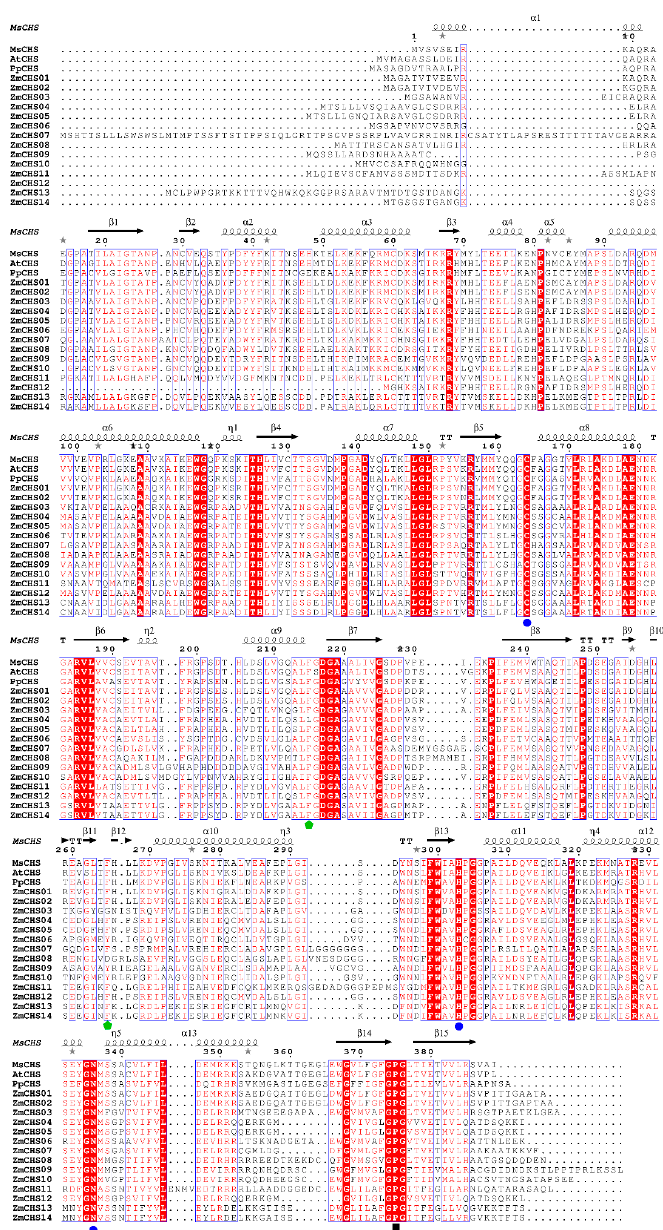
Figure 3. Sequence alignment of ZmCHSs against the other plant CHSs. The first line represents the secondary structure of Medicago sativa chalcone synthase (MsCHS). The blue boxes and red letters represent conserved residues. The red regions represent sequences of strict sequence conservation. The black wave lines and black arrows represent α -helix and β -pleated sheet. The catalytic triad of CHSs, residues connected with CoA-binding and CHS family-specific Pro375 are labeled with blue points, green pentagrams and black quadrangles at the bottom of the sequences, respectively. MsCHS = Medicago sativa (alfalfa) chalcone synthase (P30074); AtCHS = Arabidopsis chalcone synthase (AAB35812.1); PpCHS = Physcomitrella patens chalcone synthase (ABB84527.1). The “gatekeeper” phenylalanines connected with CoA-binding at positions 215 and 265 [3] are also conserved. The exceptions to these conservations are ZmCHS04 which contains a lysine substituted for phenylalanine at position 215, and ZmCHS03, -06, -08, -09 and -10 which contain